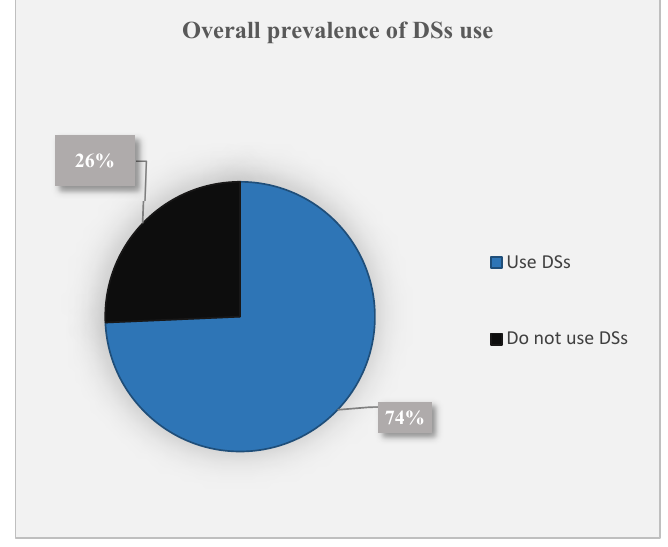
Figure 3. Overall prevalence of DSs use.